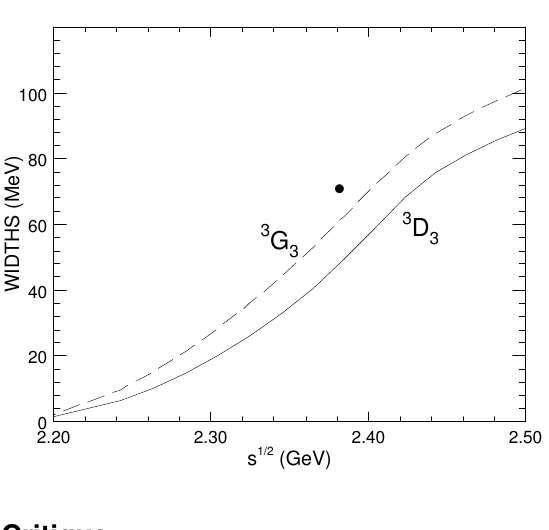
Figure 3. The widths of the ∆∆ ) state in I = 0 NN 7 S 3 ( scattering: The solid curve arises from 3 D 3 ( NN ) and the dashed one from 3 G 3 ( NN ). The bullet shows the energy and width of the resonance reported e.g. in Ref.